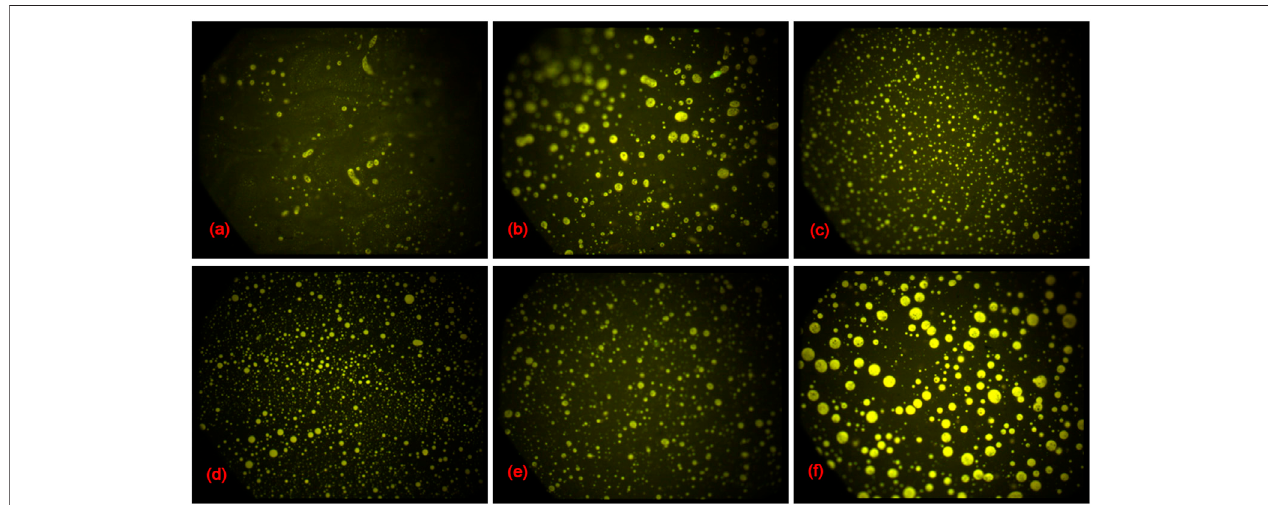
FIGURE 4 | Fluorescent microscope images, (A) specimen 2 ’ , (B) specimen 3 ’ , (C) specimen 5 ’ , (D) specimen 6 ’ , (E) specimen 8 ’ , (F) specimen 9 ’